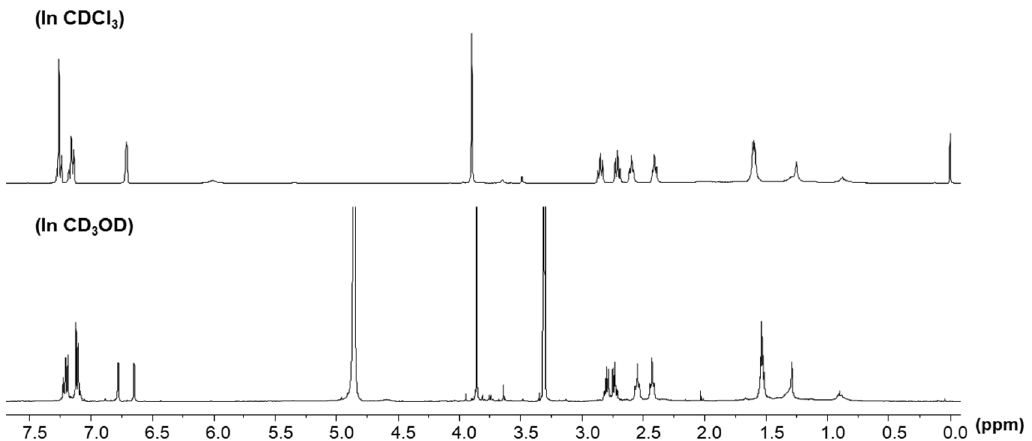
Figure 2. 1 H-NMR spectra of compound 4 in CDCl 3 and CD 3 OD (400 MHz). Six methylene signals at δ H 2.85 (2H, t, J = 7.5, H-1), 2.7 (2H, t, J = 7.5, H-2), 2.60 (2H, t, J = 7.1, H-7), 2.41 (2H, J = 7.0, H-4), 1.61 (2H, m, H-6), and 1.59 (2H, m, H-5) indicated the